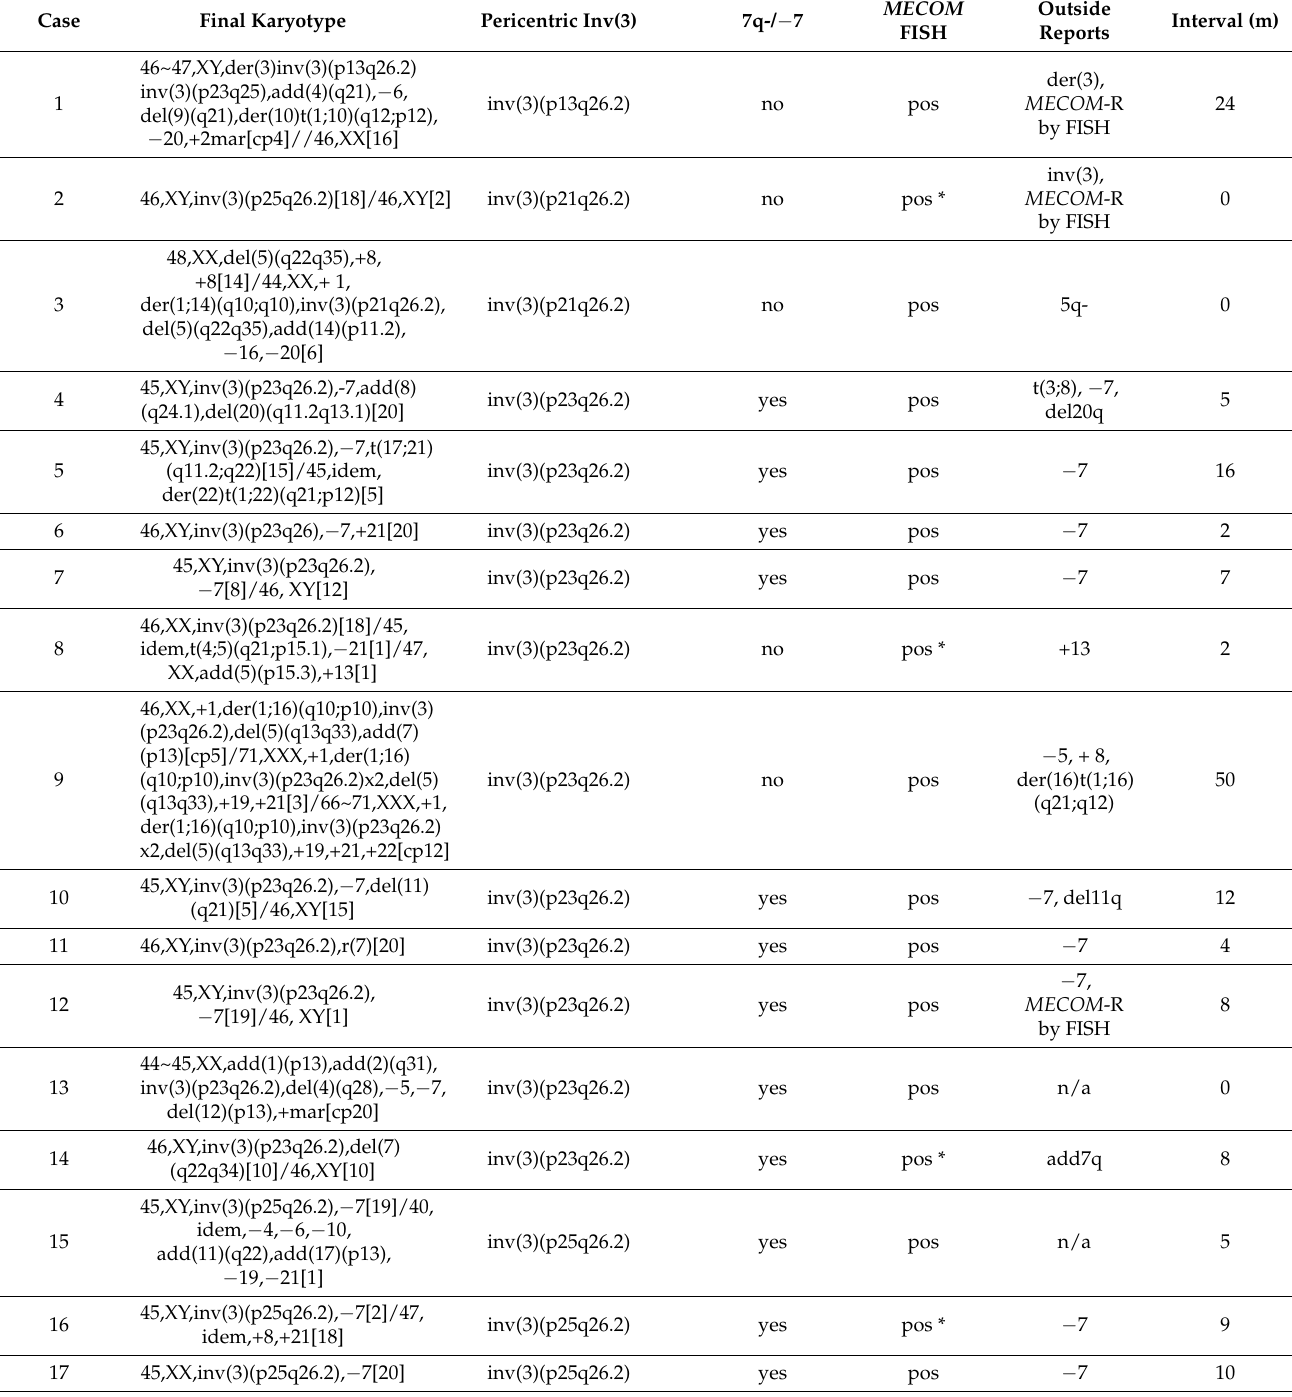
Table 3. Cytogenetic features of cases with pericentric inv(3)/ MECOM-R in this